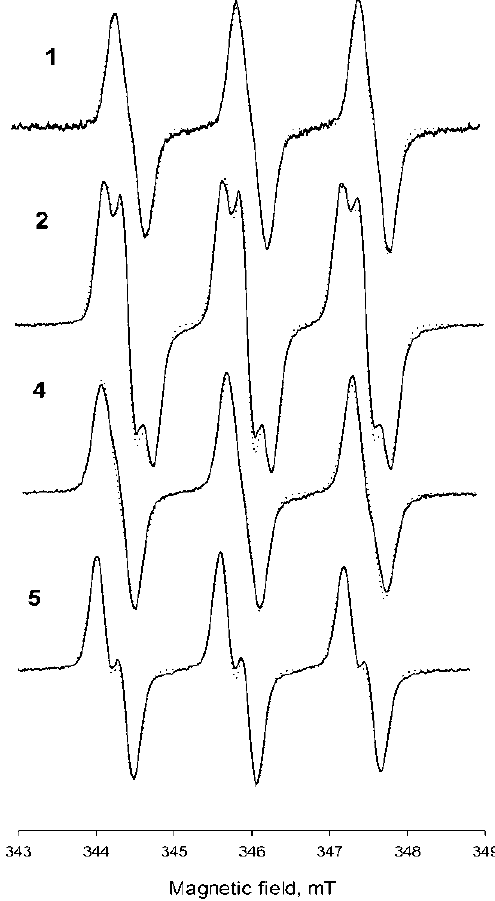
Figure 2. Electron paramagnetic resonance (EPR) spectra of studied nitroxides 1 , 2 , 4 , and 5 in 0.1 mM solutions in H 2 O. Spectrometer parameters: frequency, 9.87 GHz; microwave power, 5.0 mW; modulation amplitude, 0.05 mT; time constant, 50 ms; and conversion time, 5.12 ms. Simulations by means of WinSim are indicated by the dotted curve. Table 1. Parameters of EPR spectra, octanol–water partition coefficients (K p ), and rate constants of reduction with ascorbate for nitroxides 1 , 2 , 4 , and 5 (for details, see the experimental part). Nitroxide Solvent